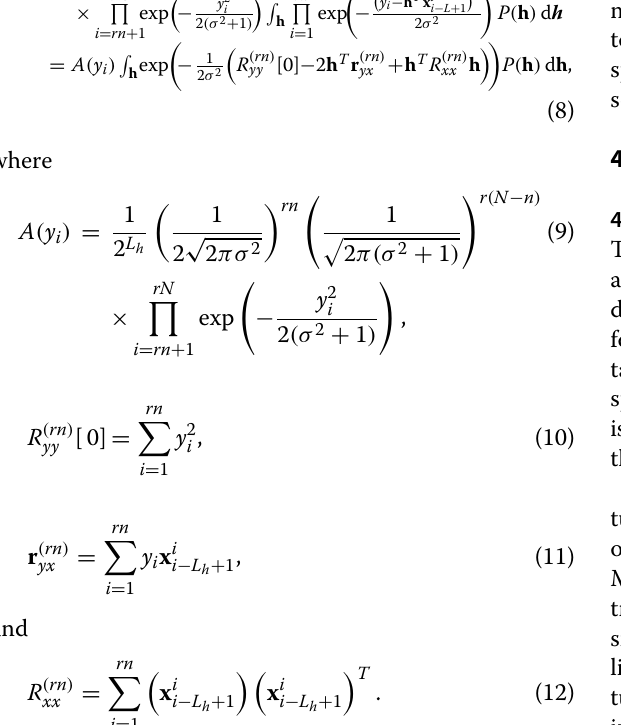
The proposed method combines the M-algorithm (MA) and the stack algorithm (SA) to perform blind sequential detection; we refer to the overall algorithm as the MA-SA for simplicity. The MA is used to find the active channel tap indices and estimate the unique binary vector d corre- sponding to the sparse channel. The path metric of the